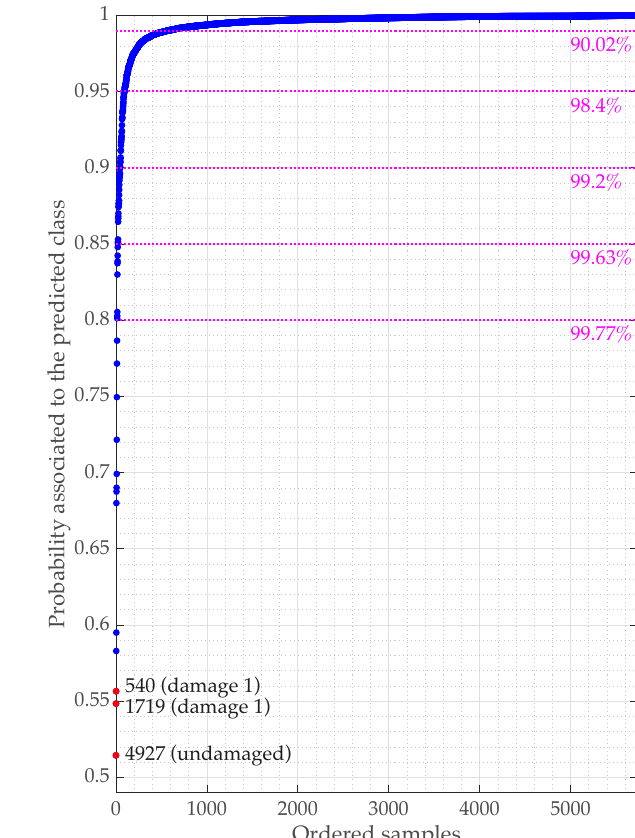
Figure 15. Probability associated with the predicted class p max ( d = 14 in the left and d = 21 in the right) for all samples ordered in the ascending order of probability p max . The misclassified samples are represented in red along with the sample number and actual class tags.